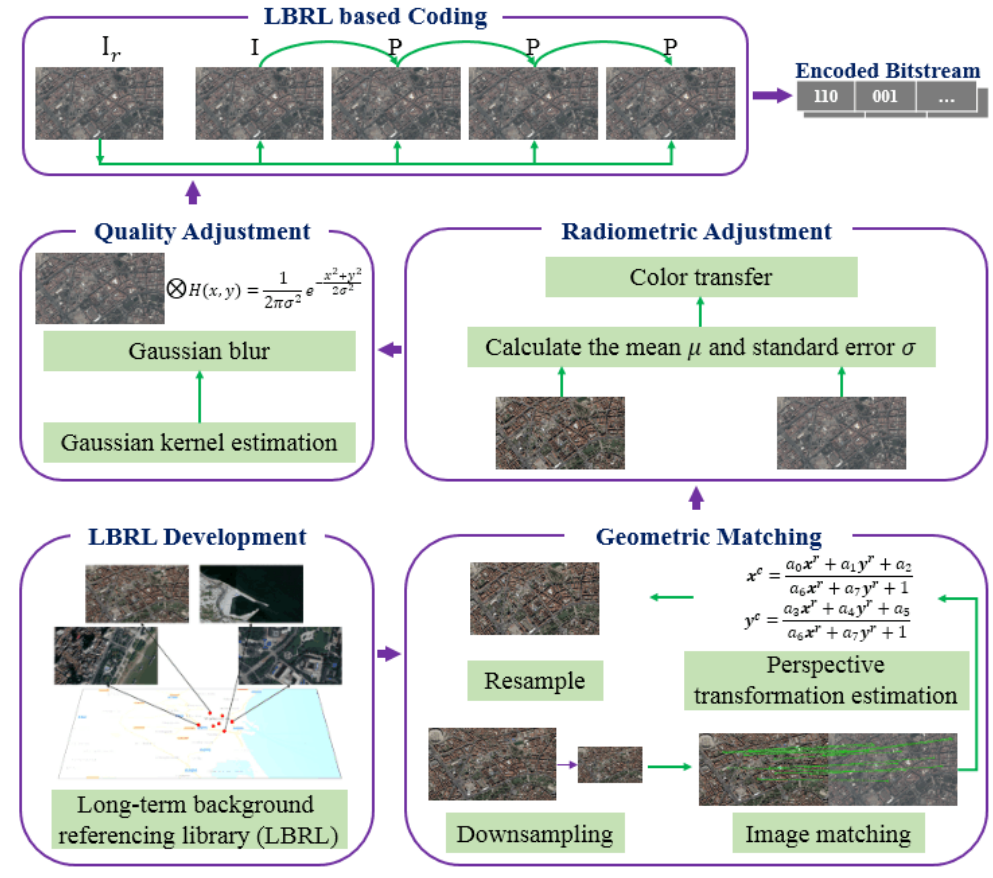
Figure 3. Overview of the proposed background reference image generation and the Earth observatory video data (EOVD) encoding using the generated reference image. Geometrical matching to the LBRL locates the correct shooting area of the current frame and transforms the area reference image from the LBRL to the target frame through projection